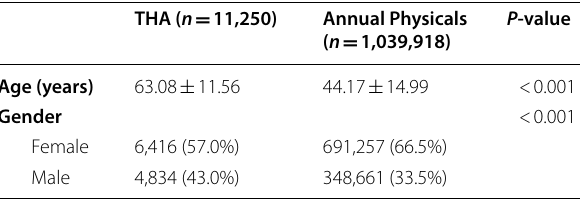
Table 1 Patient Population Comparison (2013–2020)